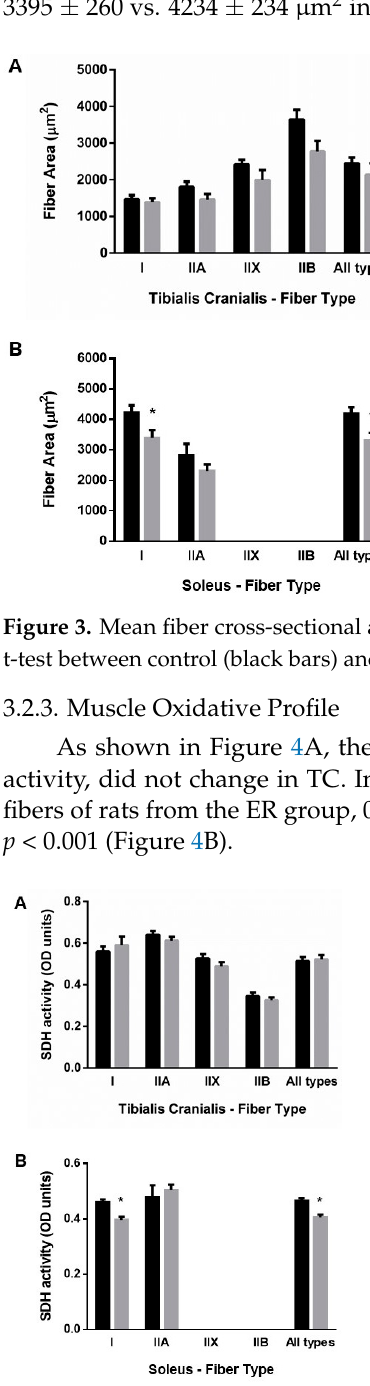
Figure 4. Mean fiber succinate dehydrogenase (SDH) activity in ( A ) tibialis cranialis and ( B ) soleus muscles. Student’s t-test between control (black bars) and energy-restricted (grey bars) groups. * p < 0.05 vs. control.